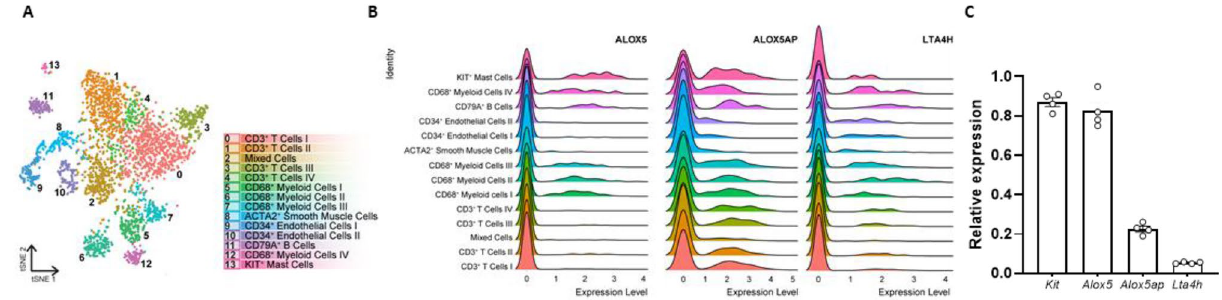
Figure 1. Expression of ALOX5 , ALOX5AP and LTA4H in both human atherosclerotic plaque cells and murine bone-marrow derived mast cells. ( A ) Single-cell RNA sequencing of human atherosclerotic plaque cells revealed 14 distinct cell clusters, including one mast cell cluster (cluster 13) 28 . In these clusters, we measured the expression of ( B ) ALOX5, ALOX5AP and LTA4H . ( C ) Expression of Kit , Alox5 , Alox5ap and Lta4h in murine bone-marrow derived mast cells. Human data n = 18; murine data: n = 4. Data represent mean ±